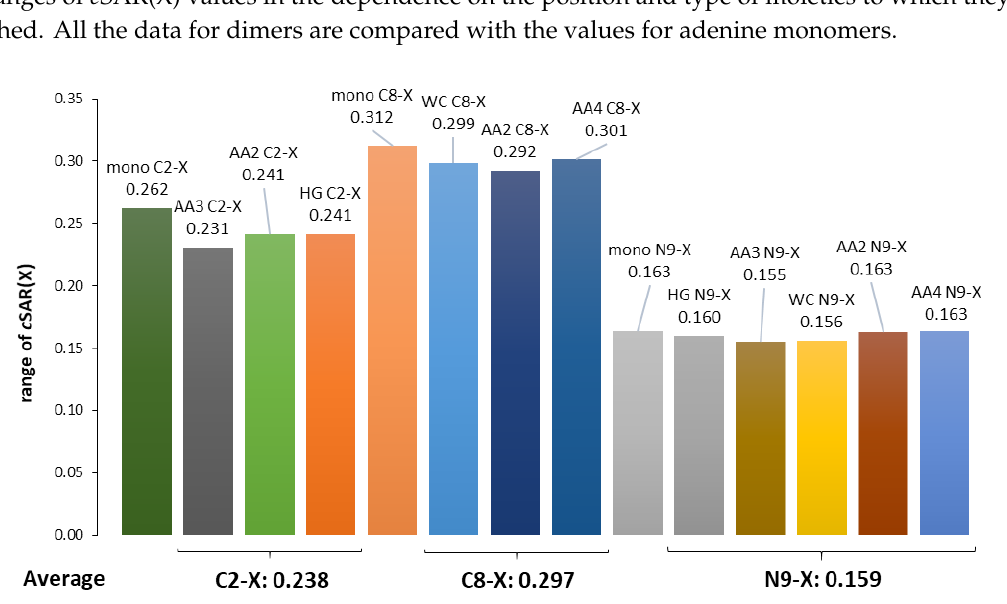
Figure 7. Ranges of c SAR(X) variability and their averaged values for substituents attached to C2, C8, and N9 in adenine monomer and its pairs (WC, HG, and adenine-adenine).